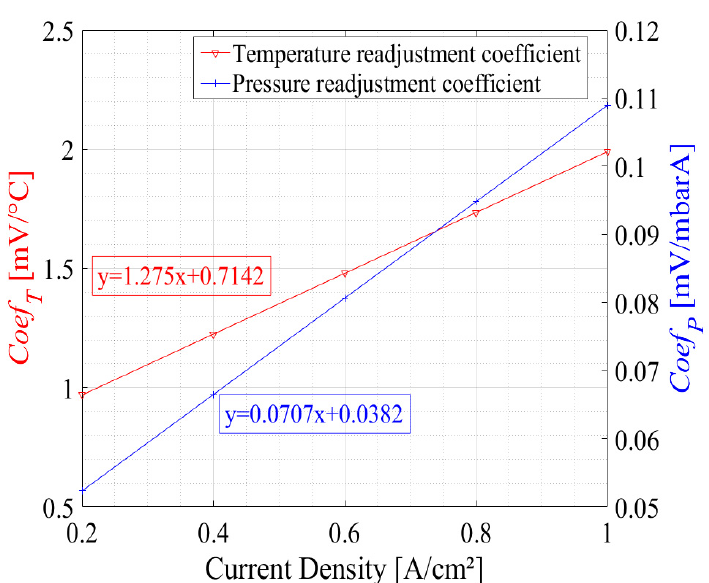
Figure 9. Generation of temperature (in red, see (5)) and pressure (in blue, see (4)) coefficients according to the current density and corresponding equations.